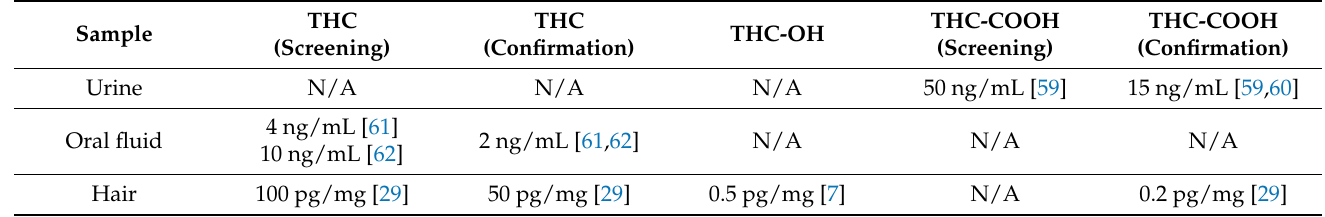
Table 2. Cut-off values for cannabinoids in different biological